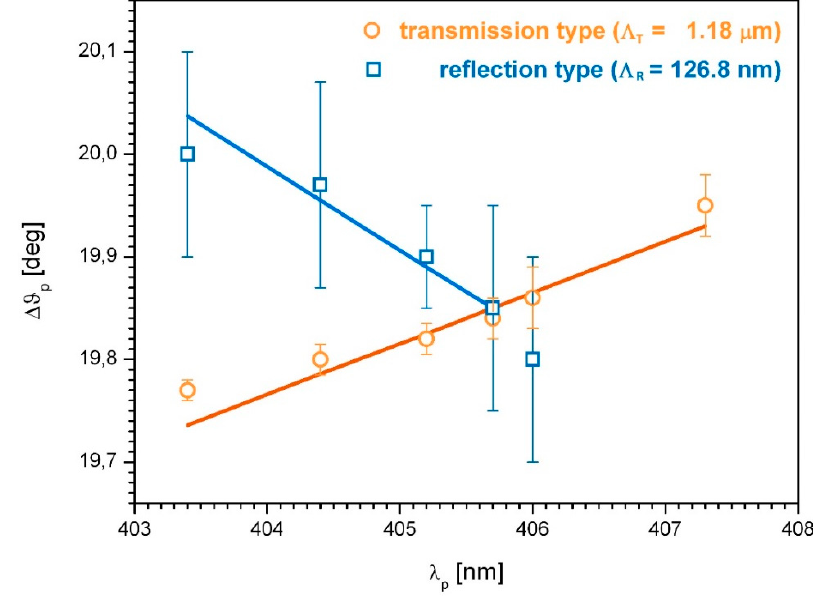
Figure 3. Bragg angle shift with probe wavelength detuning for reflection grating (blue squares) and transmission grating (orange circles), in comparison with calculation (lines) based on Λ T = 1.18 µm and Λ R = 126.8 nm.